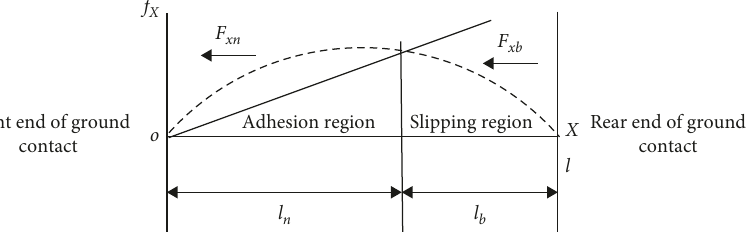
Figure 6: Schematic diagram of tire elastic slipping.